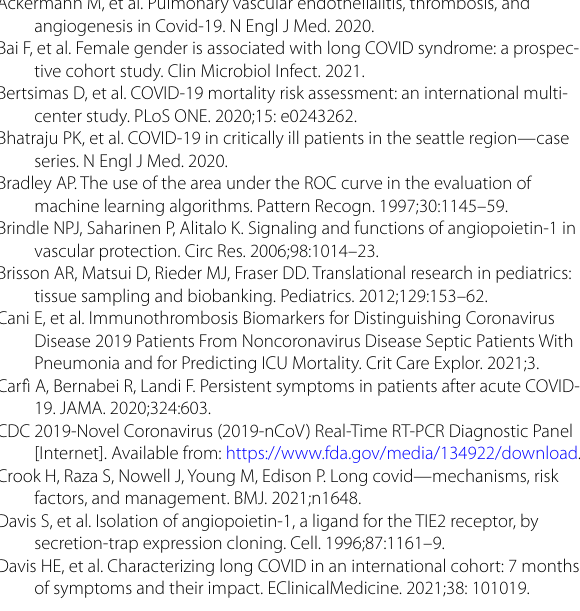
Additional file 1: Table S1 . Function of 16 Vascular Transformation Blood Biomarkers. Table S2 . Upper and Lower Limit of Quantification (ng/mL) and the Inter- and Intra-assay %CV for 16 Vascular Transforma- tion Blood Biomarkers. Table S3 : Vascular Transformation Blood Bio- marker Concentrations. Table S4 . Pair-Wise Comparisons of 16 Vascular Transformation Blood Biomarkers. Table S5 . Classification Accuracy (Random Forest) and Area-Under-the-Curve (ROC Curve Analyses) of 16 Vascular Transformation Blood Biomarkers. Table S6 . Long-COVID Validation Cohort Outpatient Demographics and Clinical Data. Fig. S1 . Boxplots and plasma concentrations days after acute infection for ANG-1 and P-SEL in a validation cohort. A) A boxplot demonstrating significantly elevated blood ANG-1 concentrations in Long-COVID outpatients (**** P 0.0001). B) A plot demonstrated ANG-1 concentration versus time = after acute infection. A cut-off value adopted from ROC analyses of the test population was calculated. C) A boxplot demonstrating significantly elevated blood P-SEL concentrations in Long-COVID outpatients